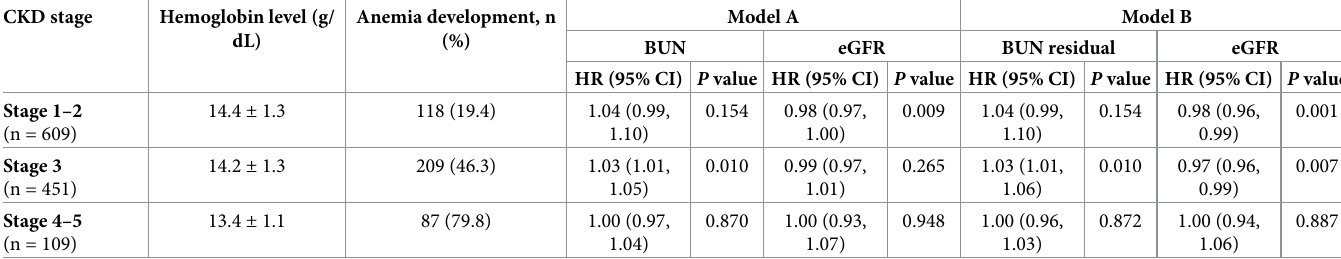
Model A: Adjusted for BUN, age, sex, smoking, SBP, DM, HTN, CCI, eGFR, log UPCR, WBC, platelet, log CRP, albumin, total cholesterol, Log ferritin, log hepcidin, iron, and TSAT, use of iron replacement therapy, ESA, ACEi or ARB, statin, and diuretics. Model B: Adjusted for BUN residual instead of BUN in model